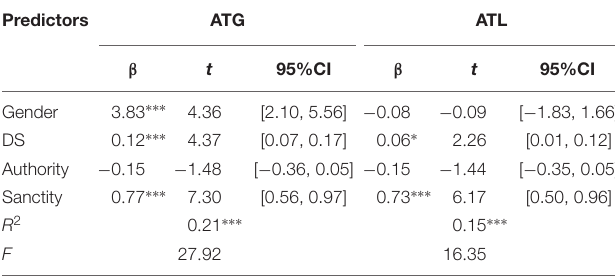
TABLE 3 | Individual associations between variables in the mediation model, where authority and sanctity were hypothesized to mediate the association between disgust sensitivity and ATG/ATL ( N =